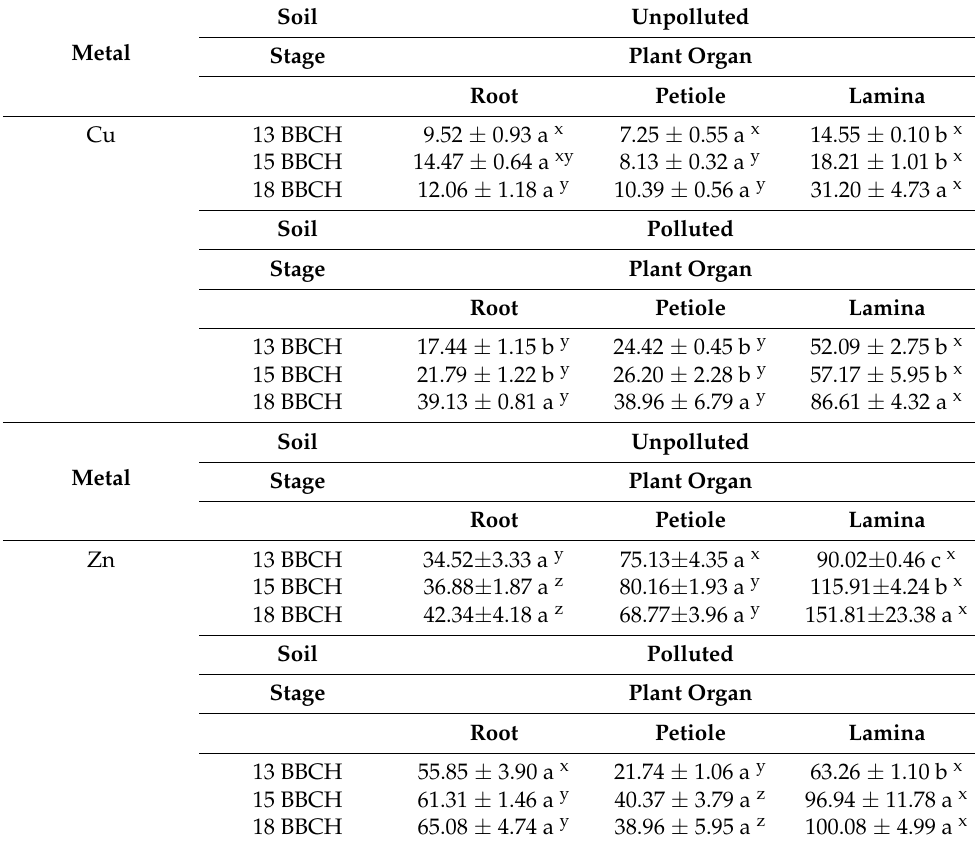
Table 5. Cu and Zn concentrations in different organs and development stages of S. perfoliatum plants grown in heavy metal Ps and